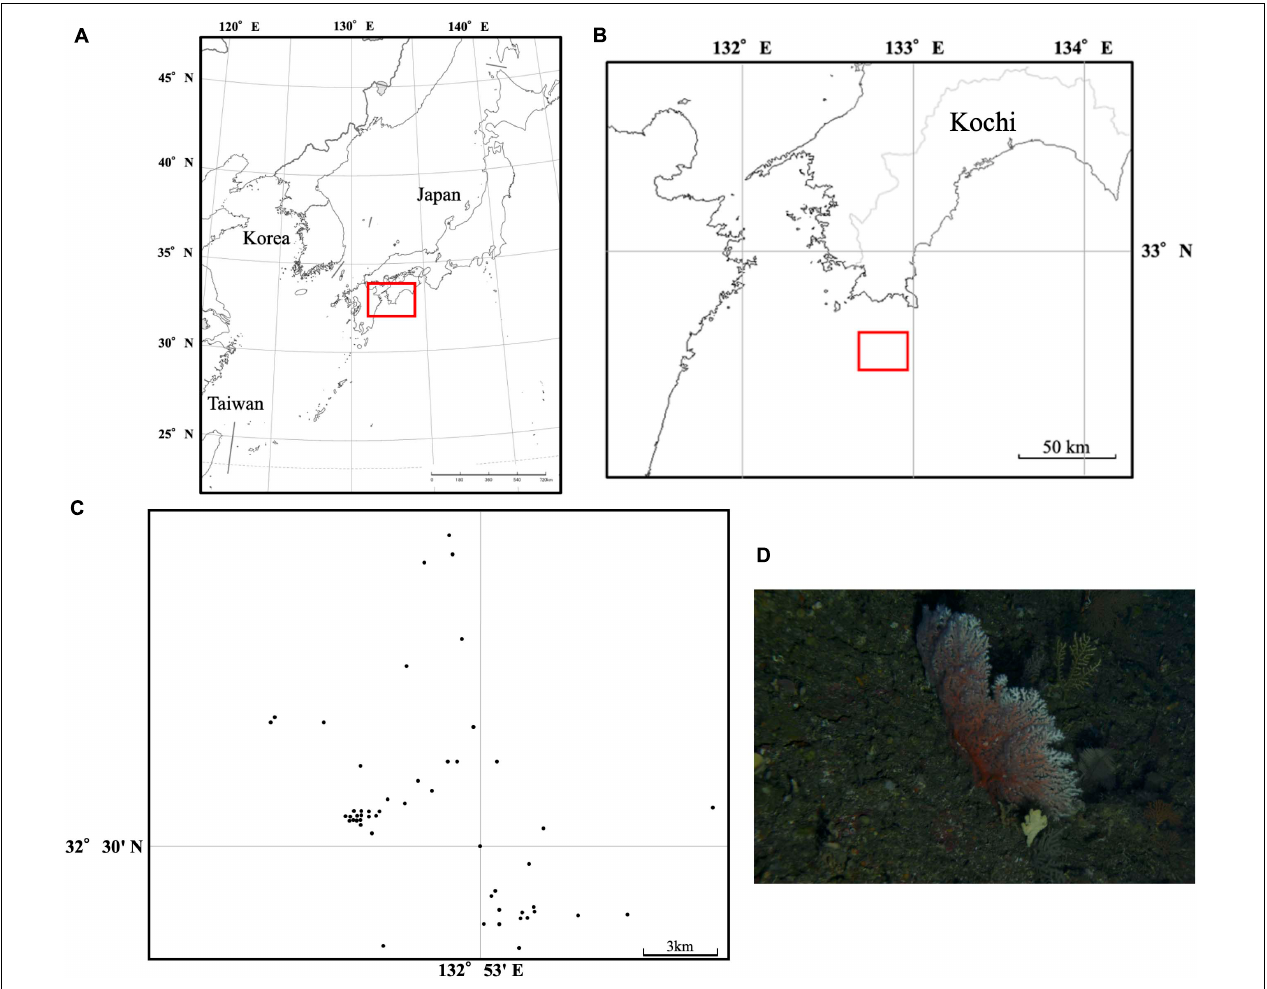
FIGURE 1 | Sampling location off Kochi (A,B) and distribution of 88 individual colonies of C. japonicum collected in this study area (C) . A picture of the Japanese red coral C. japonicum (D)